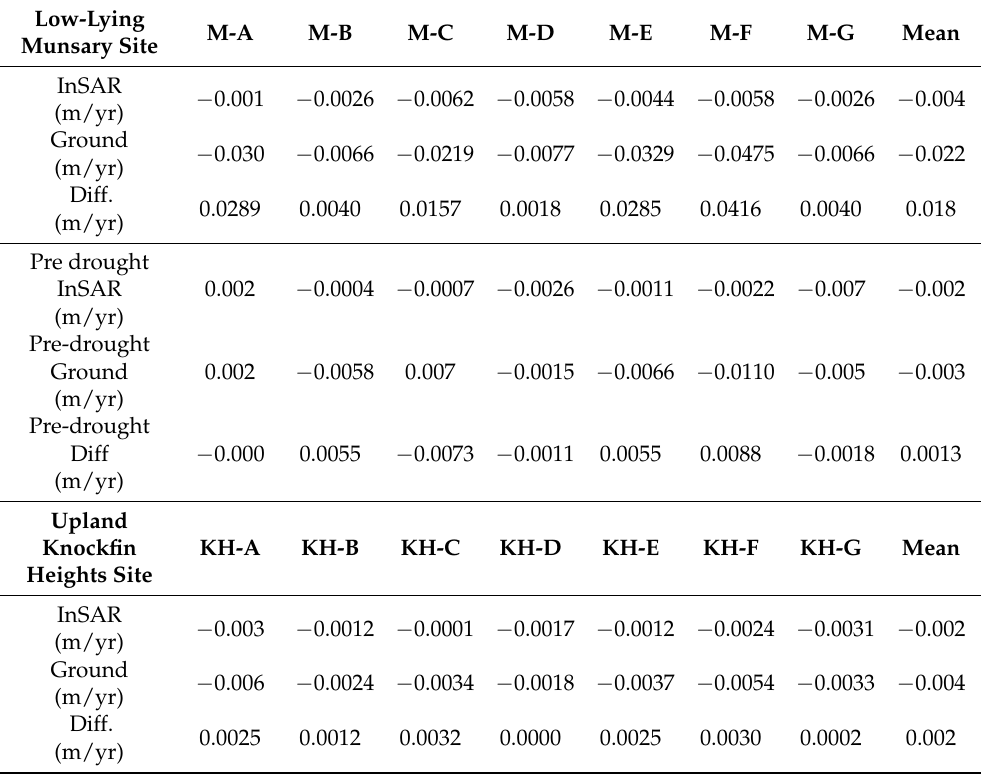
Table 2. Mean peatland surface motion pre and post drought from APSIS InSAR and Ground measurements derived from linear regression of timeseries (Pre Drought Period = 4 August 2017 to 15 May 2018; Post Drought Period (10 June 2018–20 February